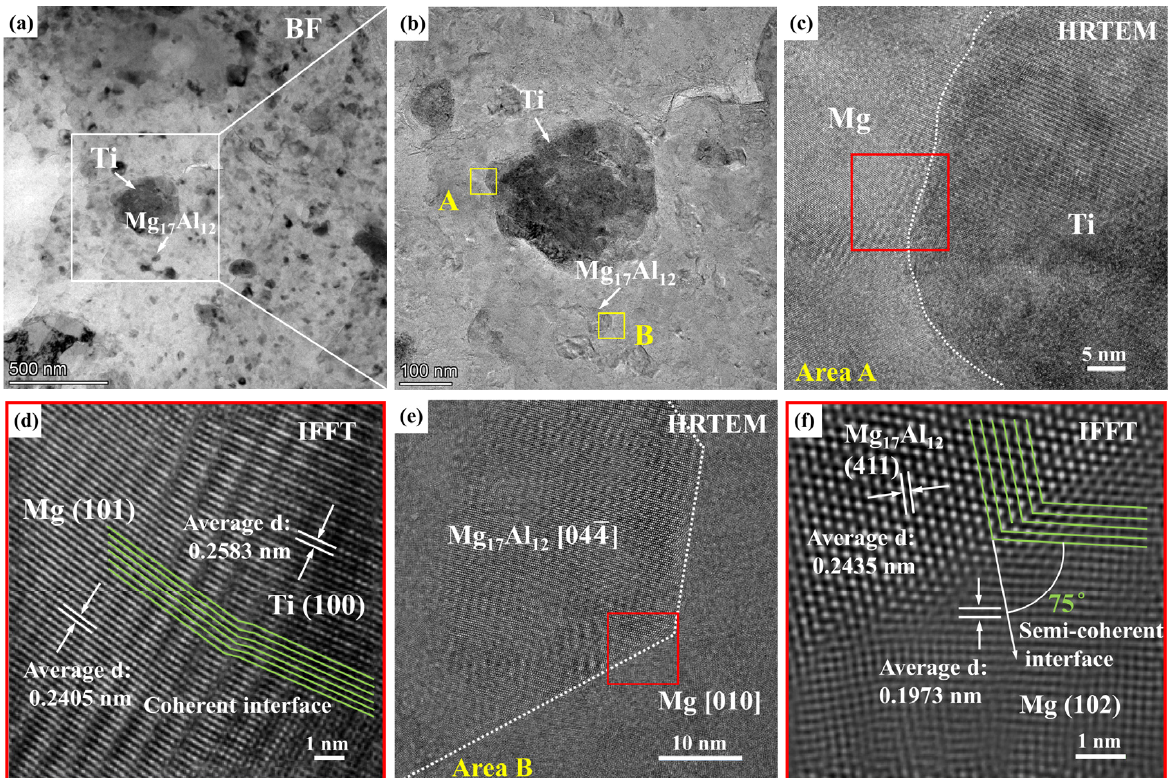
Figure 11. Microstructure of the milled Ti/Mg-9Al-Zn-0.3Mn composite: ( a ) BF image, ( b ) large view HRTEM of white square in ( a , c , e ) HRTEM of areas A and B in ( b ) characterizing Ti/Mg and Mg 17 Al 12 /Mg interface, ( d , f ) IEEF image of square regions.